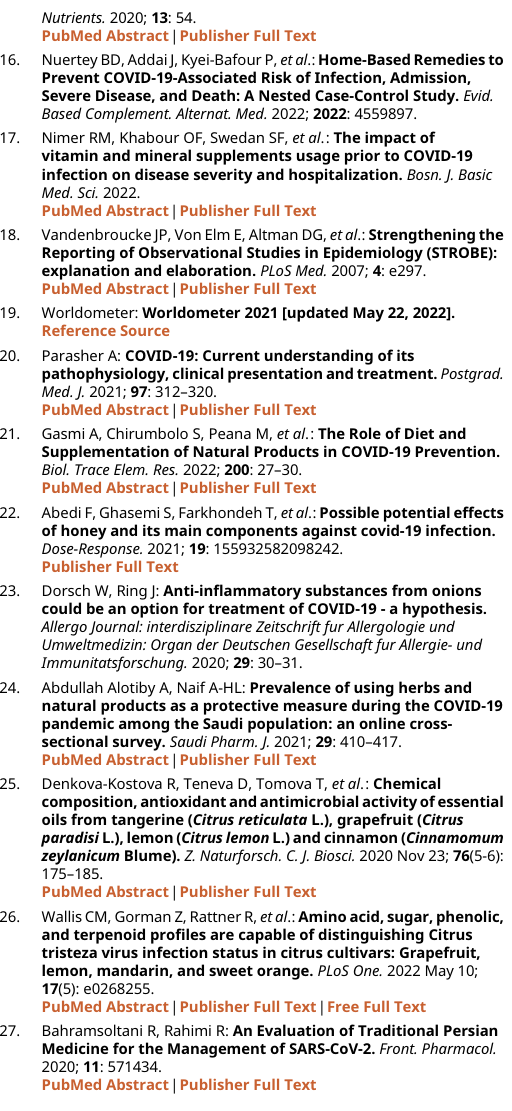
This project contains the following underlying data: